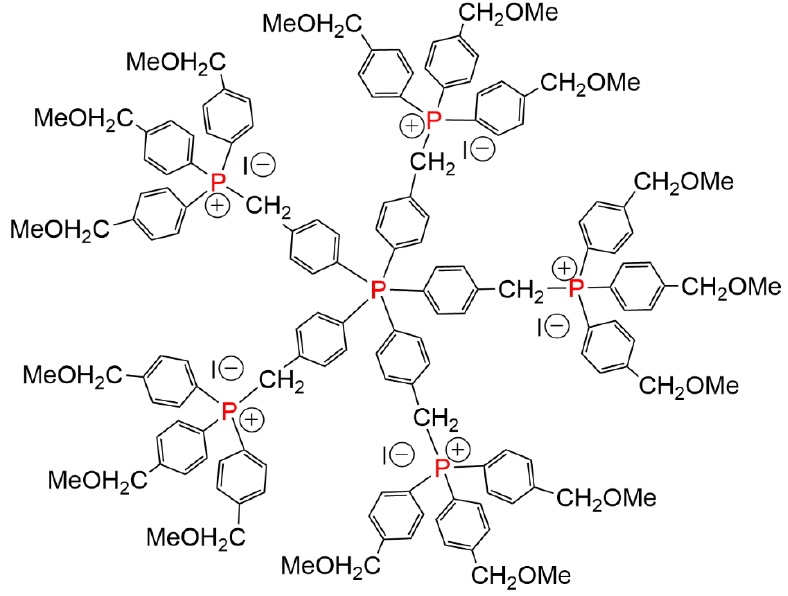
Figure 3. Phosphonium dendrimer built from a quinque-directional phosphorane core.